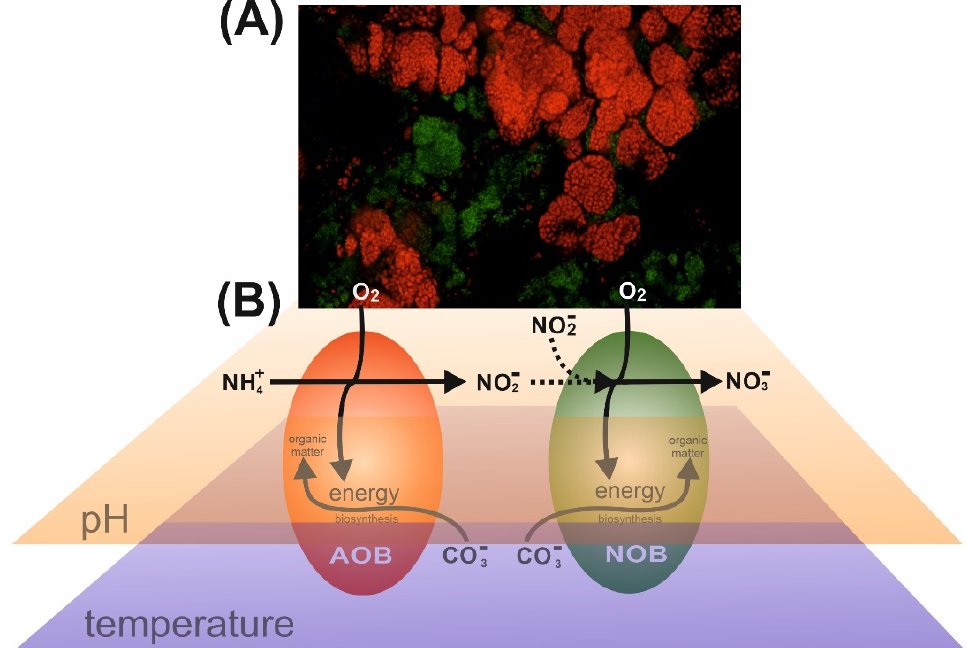
Figure 1. Biosensor based on consortia of nitrifying bacteria (ABTOW). ( A ) spatial arrangement of colonies of ammonium-oxidizing bacteria (AOB, red) and nitrite-oxidizing bacteria (NOB, green) in an ABTOW. ( B ) Schematic view of nitrification, catalyzed by AOB (first stage of nitrification) and NOB (second